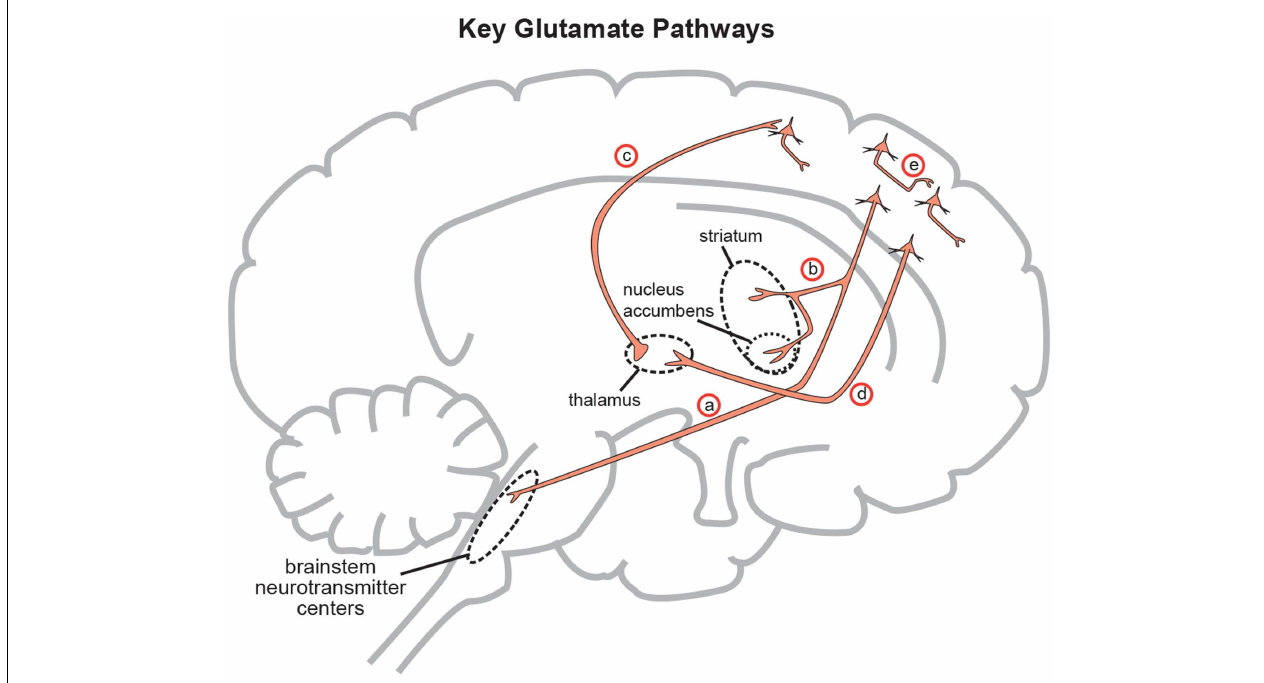
FIGURE 3 | Five glutamate pathways. (a)The cortical brainstem glutamate projection is a descending pathway that projects from cortical pyramidal neurons in the prefrontal cortex to brainstorm neurotransmitter centers (raphe, locus coeruleus, ventral tegmental area, substantia nigra) and regulates neurotransmitter release. (b) Another descending glutamatergic pathway projects from the prefrontal cortex to the striatum (corticostriatal glutamate pathway) and to the nucleus accumbens (cortico-accumbens glutamate pathway), and constitutes the “corticostriatal” portion of cortico-striatal-thalamic loops. (c)Thalamocortical glutamate pathways